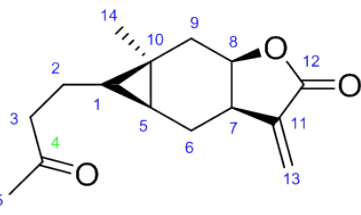
Figure 1. The structure of